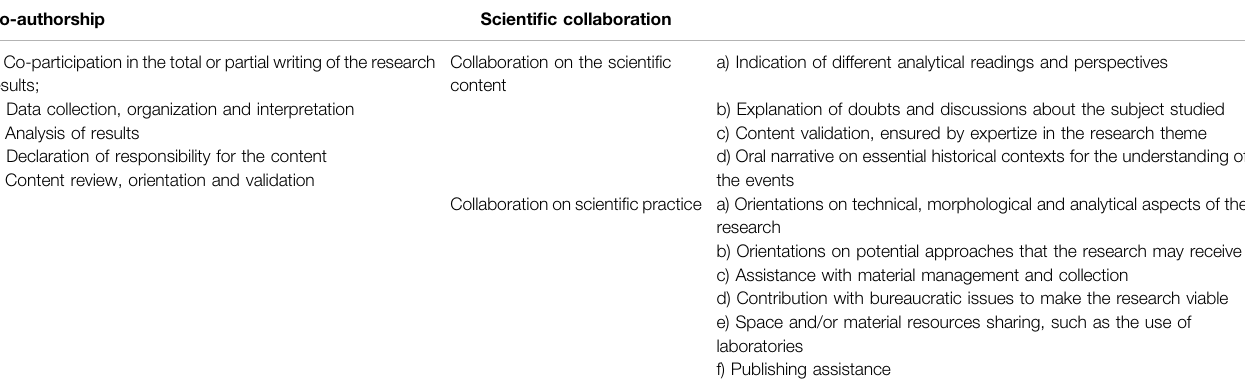
TABLE 1 | Characteristics of co-authorship and collaboration in scienti fi c